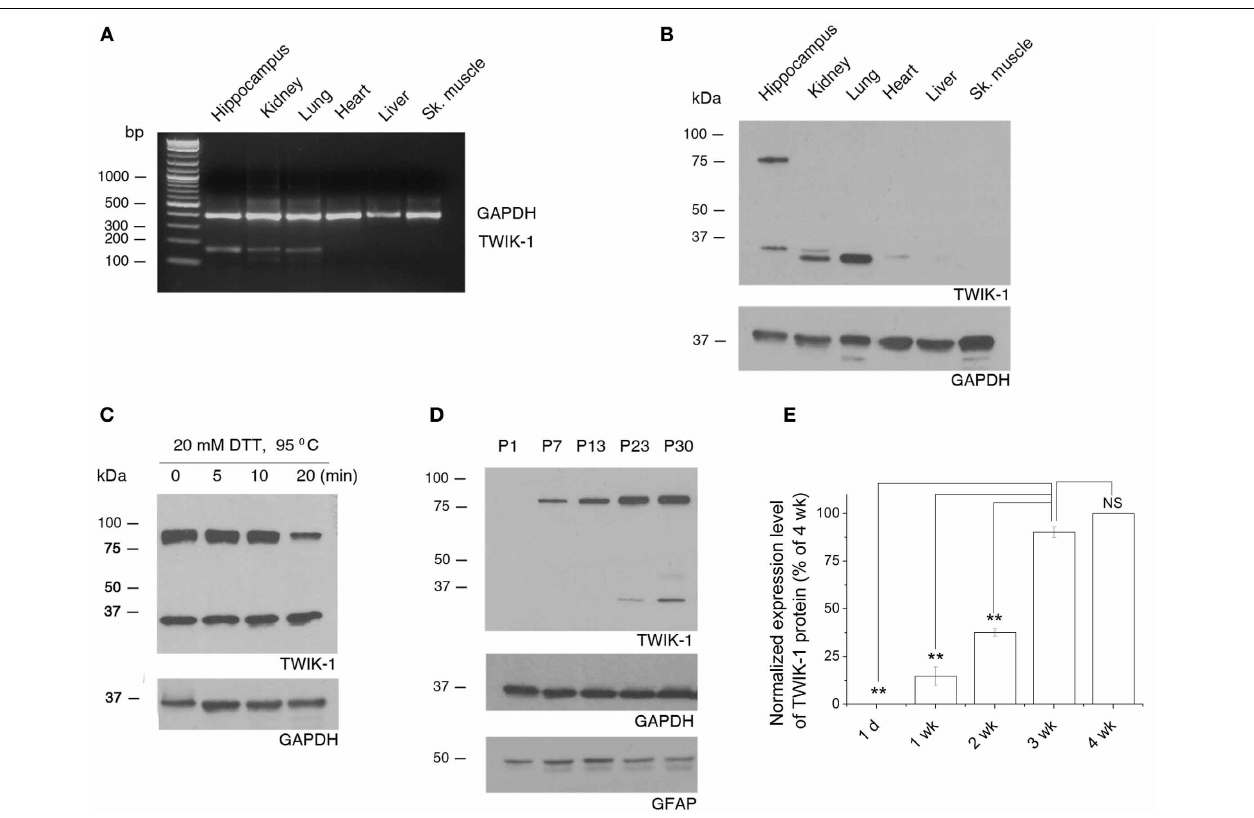
FIGURE 7 | Tissue specific expression of TWIK-1 mRNA and proteins and age-dependent up-regulation of TWIK-1 in hippocampus. (A) RT-PCR analysis of TWIK-1 mRNA expression in various adult mouse tissues. TWIK-1 mRNA expression is high in hippocampus, kidney and lung, but barely detectable from heart, liver and skeletal (Sk.) muscle. GAPDH was measured as internal control. The PCR product size for TWIK-1 and GAPDH gene were 191bp and 394bp, respectively. (B) Representative Western blot results analyzed from various tissues noted above. Note that TWIK-1 protein expression followed exactly the same